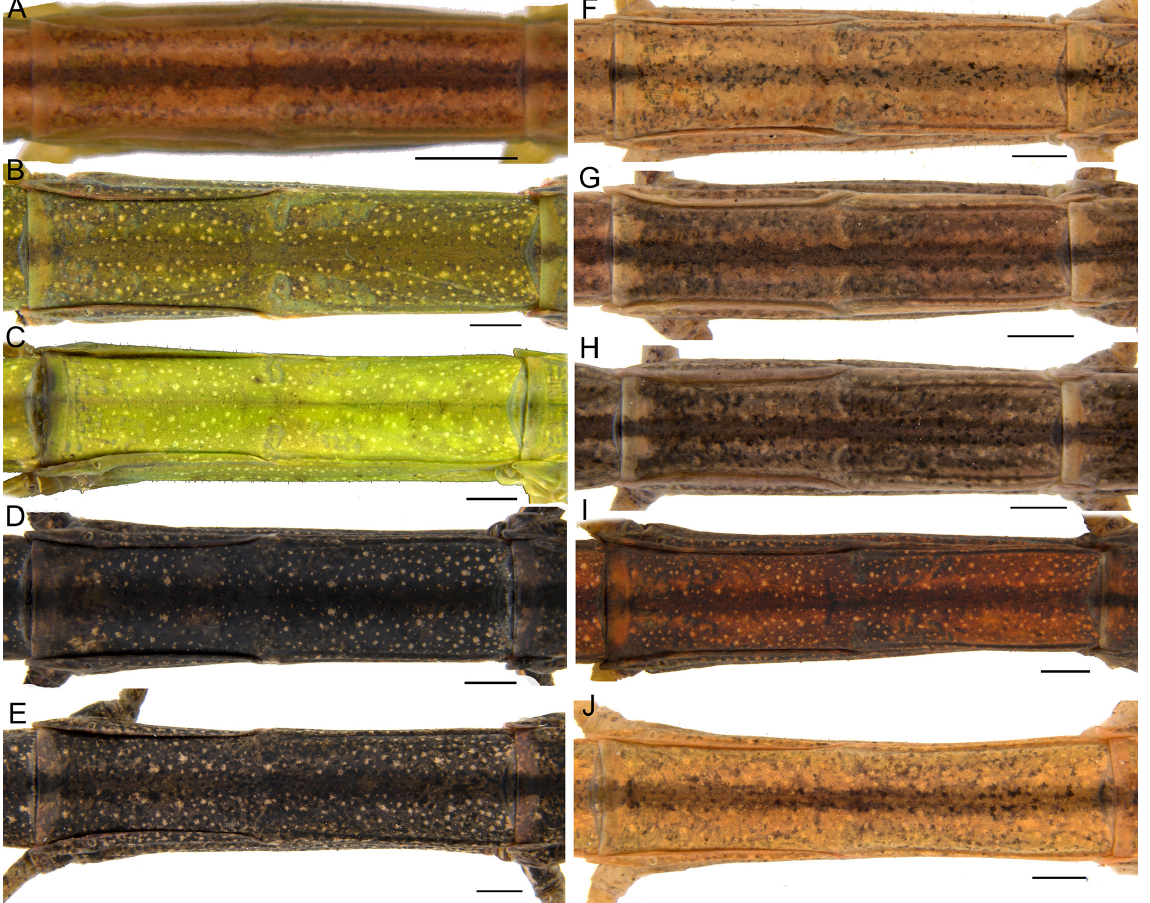
Fig. 13. Colour variation of Arumatia dubia (Caudell, 1904) gen. et comb. nov., showing metathorax and median segment of females. A–B . ♀ (MZUSP V0561) from Ibaté when nymph (A) or adult